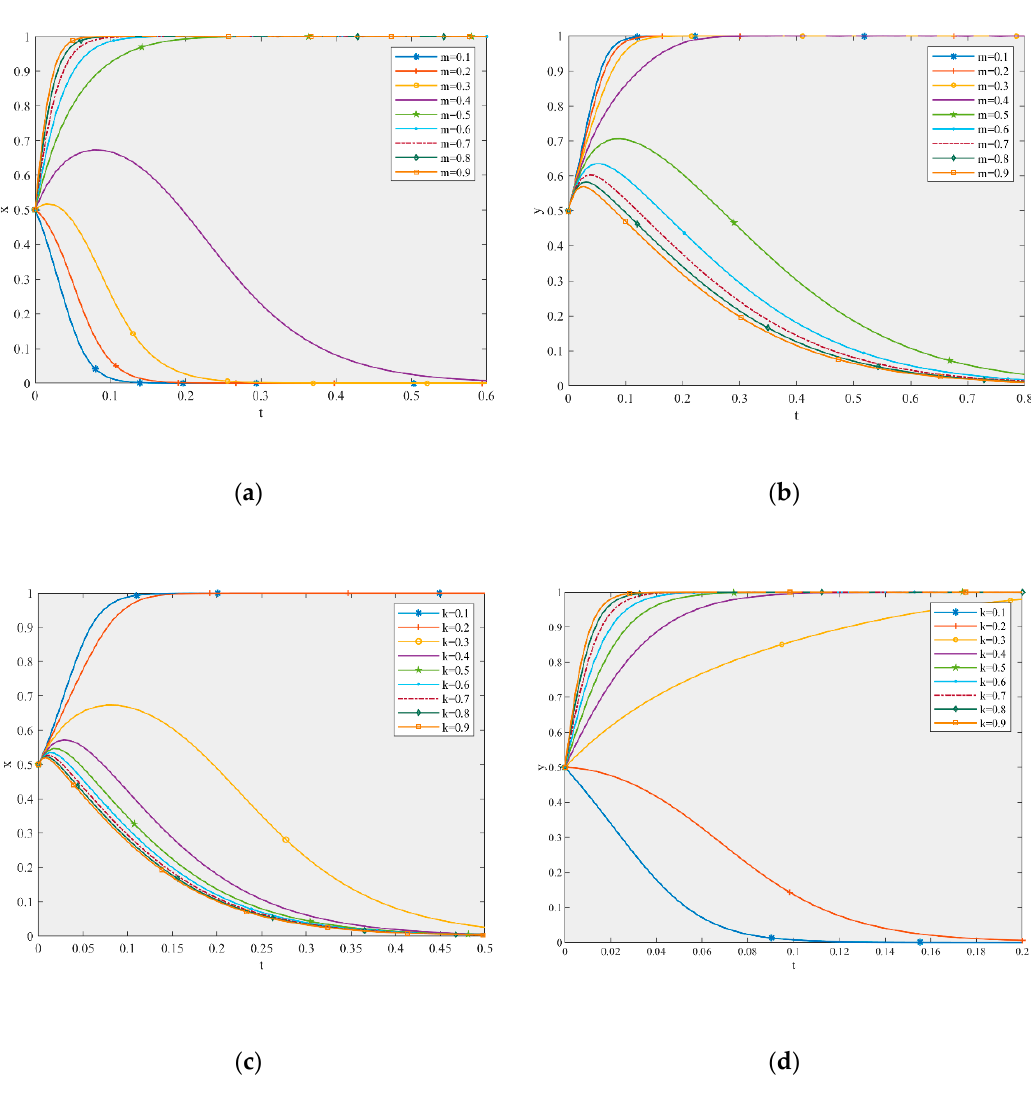
Figure 3. The e ff ect of m ( a ) on the production unit and ( b ) the recycling unit, and the e ff ect of k ( c ) on Figure 3. The effect of m ( a ) on the production unit and ( b ) the recycling unit, and the effect of k ( c ) the production unit and ( d ) the recycling unit in the game on the production unit and ( d ) the recycling unit in the game equilibrium.